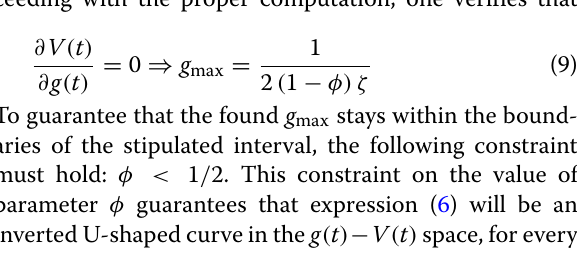
A ( t ) = A l φ ; while the upper-bound on g ( t ) , g ( t ) = 1 ζ , cor- responds to the no social damage circumstance such that A ( t ) = A l . The specified problem is specially meaningful if an inte- rior optimum exists, i.e., if the maximum of V ( t ) in Eq. (6) is found for a level of g ( t ) such that 0 < g max < 1 ζ . Pro-